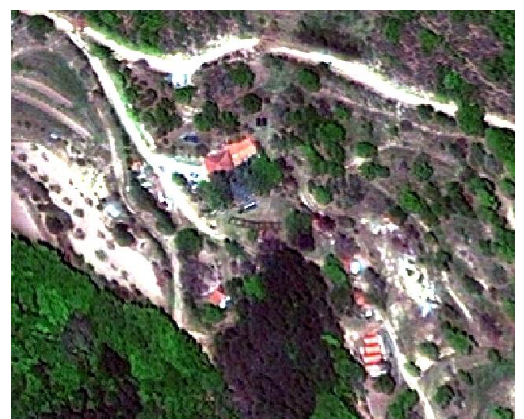
Figure 13. An extract of the fused